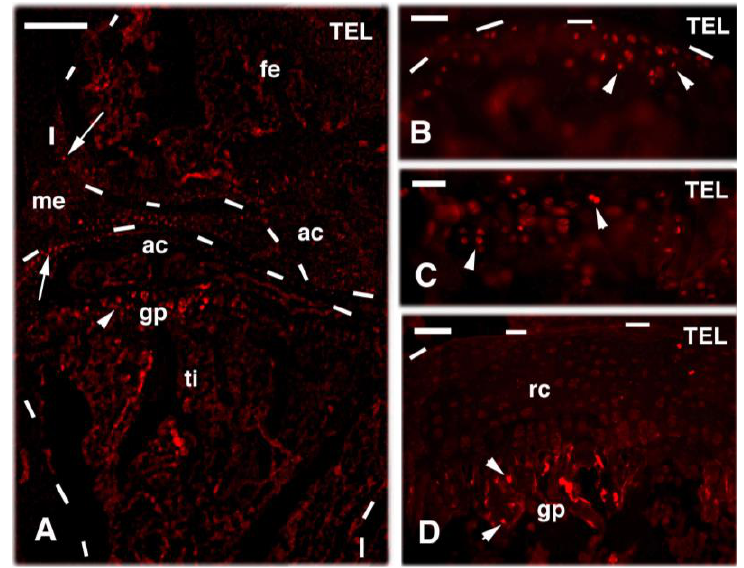
Figure 6. Telomerase immunolocalization in normal ( A – C ) and 28 days regenerated ( D ) knee epiphyses. ( A ) few cells appear labeled in the articular cartilage (arrows) and growth plate (arrowheads). Bar, 50 μm; ( B ) detail on labeled cells (arrowheads) present in the articular cartilage of a normal femur. Bar, 20 μm; ( C ) other detail showing few labeled cells (arrowheads) located in the growth (metaphyseal) plate of the femur. Bar, 20 μm; ( D ) few labeled cells are still visible in the growth plate (arrowheads) while the remaining regenerated cartilage is almost devoid of labeled cells. Bar, 20 μm. Legends: ac, articular cartilage; fe, femur; gp, growth plate; me, meniscus; rc, regenerated cartilage of the epiphysis. ti, tibia. Dashes outlined the shape of cartilages and bones.